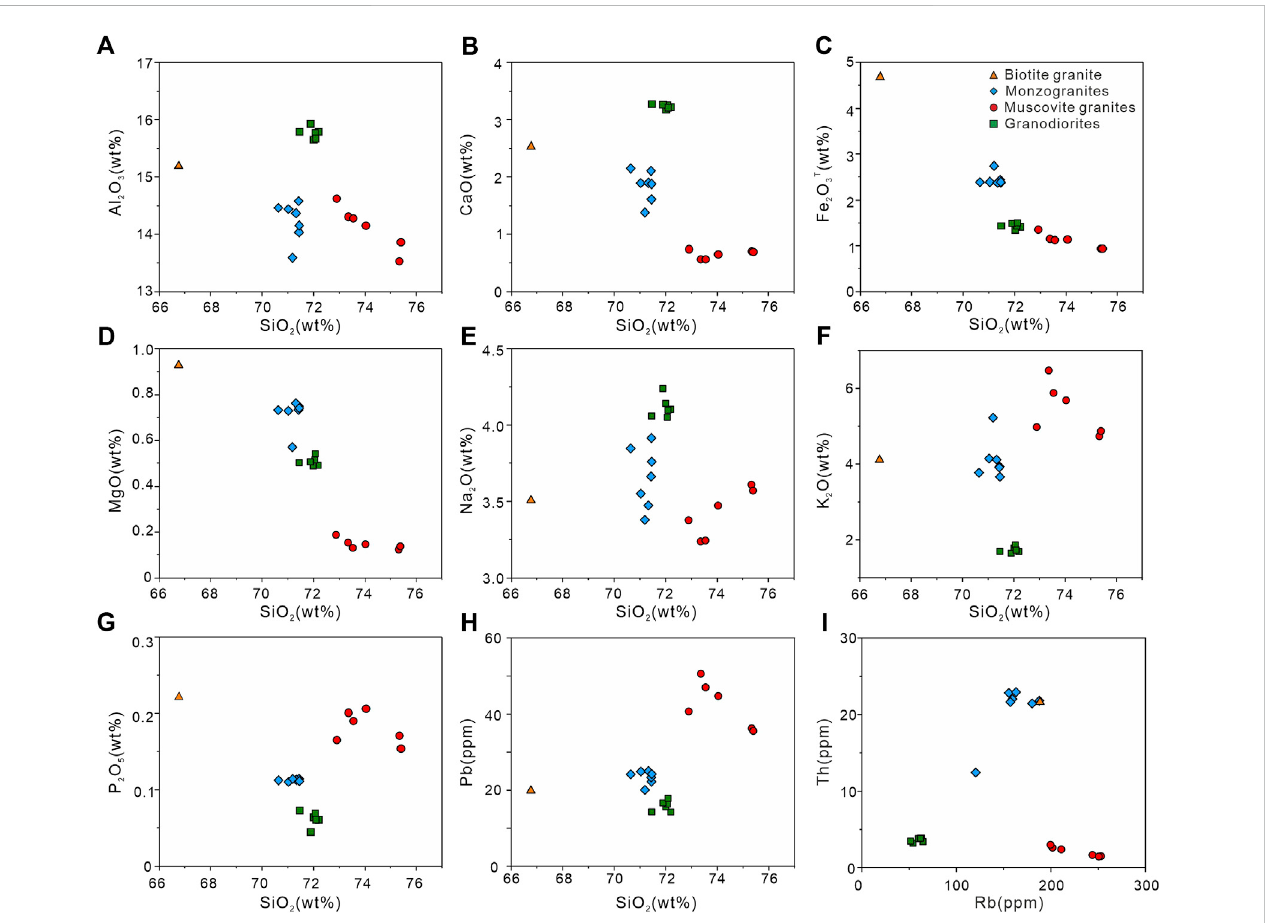
FIGURE 9 (A) Al 2 O 3 vs . SiO 2 , (B) CaO vs .SiO 2 , (C) Fe 2 O 3 T vs . SiO 2 , (D) MgO vs . SiO 2 , (E) Na 2 O vs .SiO 2 , (F) K 2 O vs . SiO 2 , (G) P 2 O 5 vs . SiO 2 , (H) Pb vs . SiO 2 , and (I) Rb vs . Th variation diagrams, showing that muscovite granites in the Huatugou area follow chemical trends of S-type proposed by Chappell (1999).